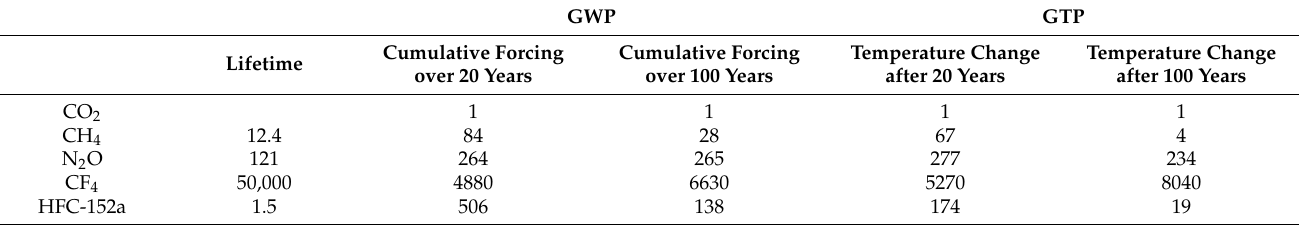
Table 9. GWP and temperature change potential (GTP) emission parameters [20] result from 1 kg CO2. GWP